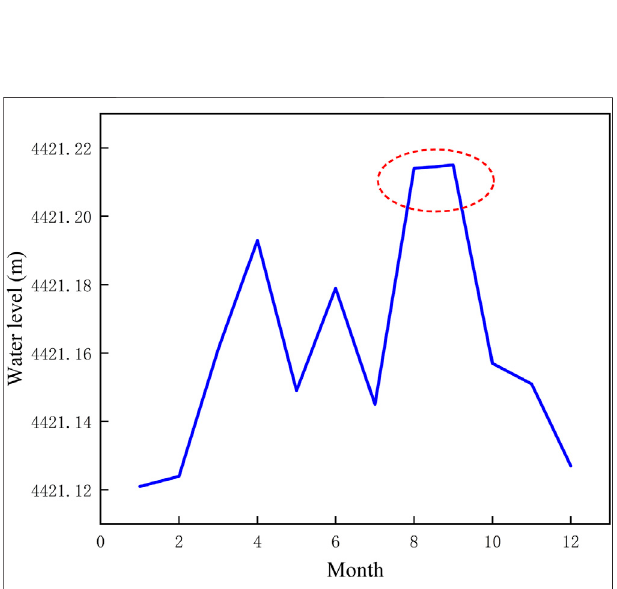
FIGURE9| VariationinthemonthlyaveragewaterlevelintheNorthLake of Zabuye Salt Lake from 2011 to